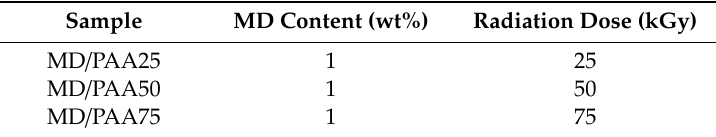
Figure 1. ( a ) A schematic illustration of MD / PAAc hydrogel films using gamma-ray. ( b ) Optical images of radiated 1 wt% MD solution with di ff erent radiation dose (0, 25, 50, and 75 kGy) ( c ) Optical images of MD / PAAc hydrogel film with di ff erent concentration of MD. Table 1. Characteristics of metronidazole containing poly (acrylic acid) hydrogel films with di ff erent radiation doses.